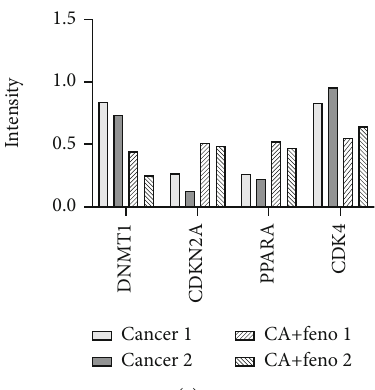
Figure 8: Feno fi brate suppressed tumor growth and DNMT1 content in vivo . (a) Representative images of subcutaneous xenografts from the treatment and vehicle groups ( n = 6 mice per group). Subcutaneous xenograft growth curves of nude mice of the two groups. Body weight of each mouse was recorded every three days. Data was presented as mean ± SD . (b) H&E staining of subcutaneous xenografts from the treatment group and vehicle group (magni fi cation 200x). (c) The DNMT1 value of tissues was examined using ELISA assay. Data was presented as mean ± SD ( ∗ P < 0 : 05 , ∗∗ P < 0 : 01 , ∗∗∗ P < 0 : 001 ). (d) DNMT1, PPARA, CDK4, and CDKN2A mRNA expressions of xenografts from two groups were detected using qRT-PCR. Data was shown as mean ± SD ( ∗ P < 0 : 05 , ∗∗ P < 0 : 01 , ∗∗∗ P < 0 : 001 ). (e) DNMT1, PPARA, CDK4, and CDKN2A protein levels in di ff erent groups were measured by western